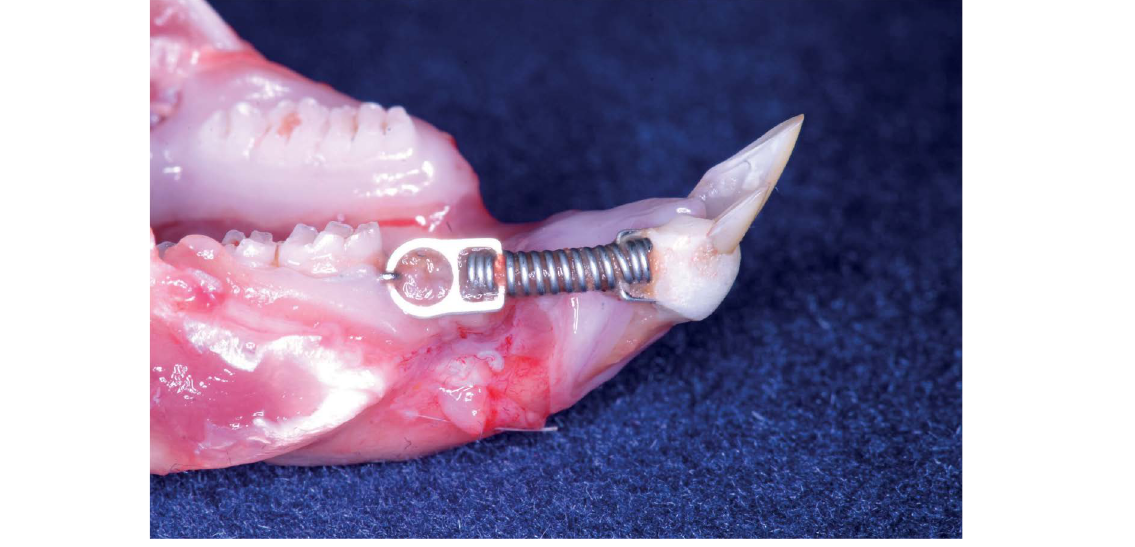
Figure 1. Orthodontic appliance, composed of a 4.0-mm NiTi closed coil spring, installed between the right mandibular first molar and right mandibular central